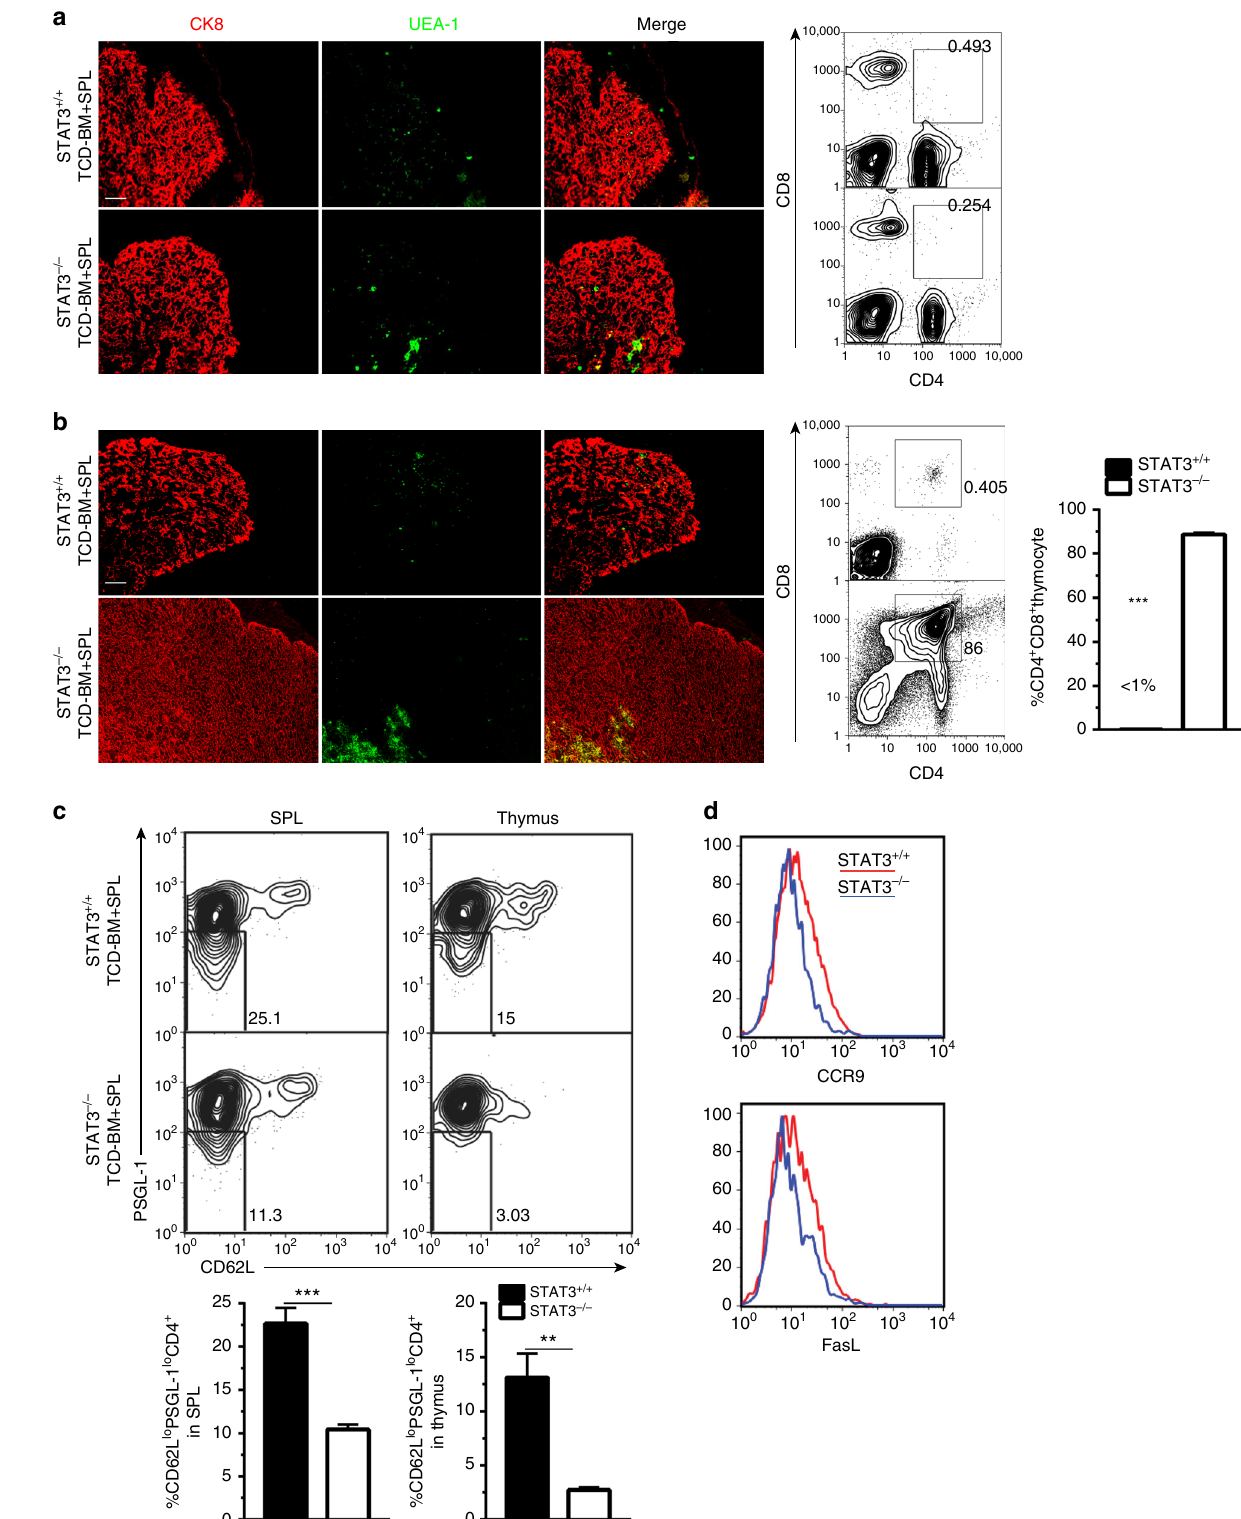
Fig. 8 Thymus recovery in recipients given Stat3 − / − transplants is associated with reduced PSGL-1 lo CD4 + T-cell in fi ltration in the thymus. BALB/c recipients were conditioned with 850 cGy TBI and given 2.5 × 10 6 TCD-BM plus 1 × 10 6 splenocytes from either WT or CD4-Stat3 − / − C57BL/6 donors. a , b 10 days ( a ) and 30 days ( b ) after HCT, thymus specimens were harvested and stained with CK8 for the cortex and UEA-1 for the medulla epithelial cells. Percentage of CD4 + CD8 + thymocytes was measured with fl ow cytometry. c Ten days after HCT, spleen and thymus were harvested and stained for CD4, CD44, PSGL-1, and CD62L. Gated CD4 + CD44 hi are shown as PSGL-1 versus CD62L. PSGL-1 lo CD62L lo CD4 + CD44 hi cells were identi fi ed as extrafollicular PSGL1 lo CD4 + T cells. Percentages of PSGL-1 lo CD4 + T cells among CD4 + CD44 hi cells are shown as mean ± SE ( n = 6). d CCR9 and FasL expression on splenic PSGL-1 1o CD4 + T cells were measured by fl ow cytometry and one representative histogram is shown ( n = 6). Scale bar , 50 µ